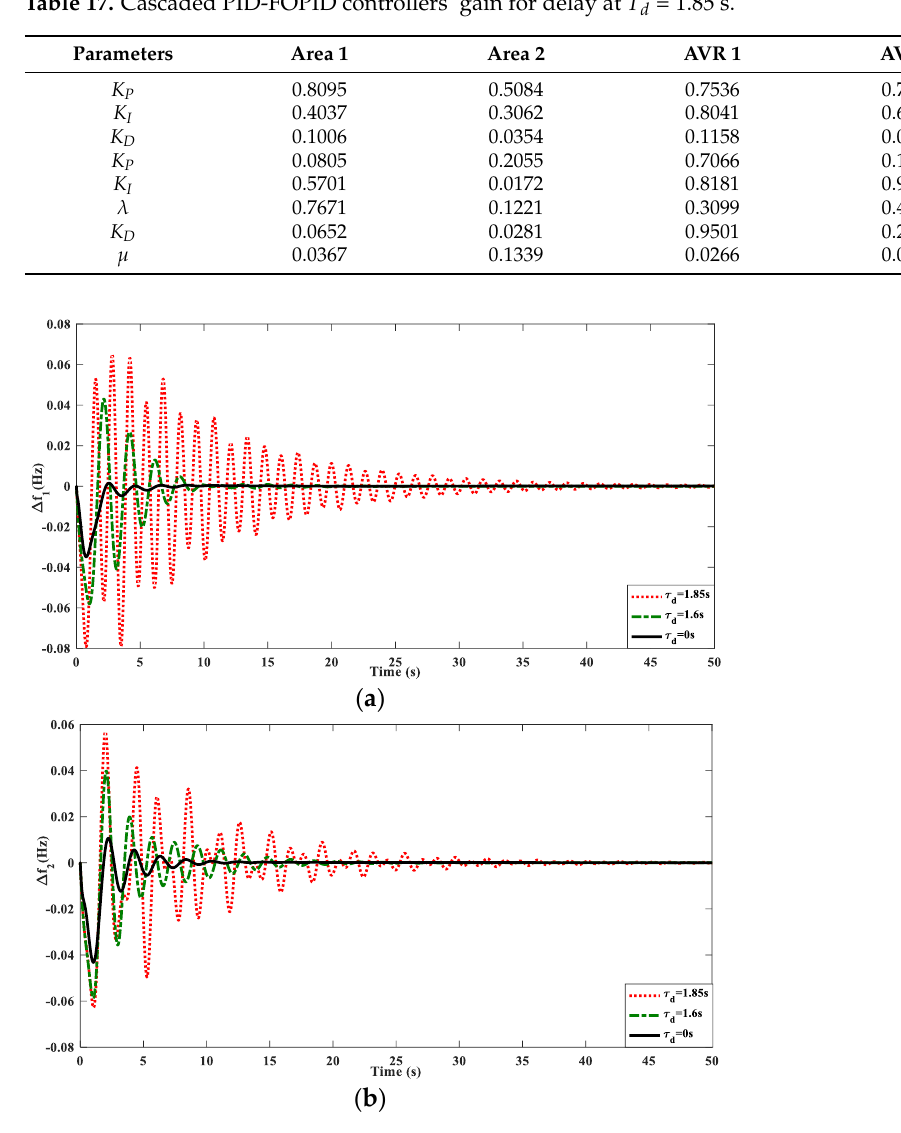
Table 15. Numerical values of T s (s) , M P , and U P for AVR. Coordination